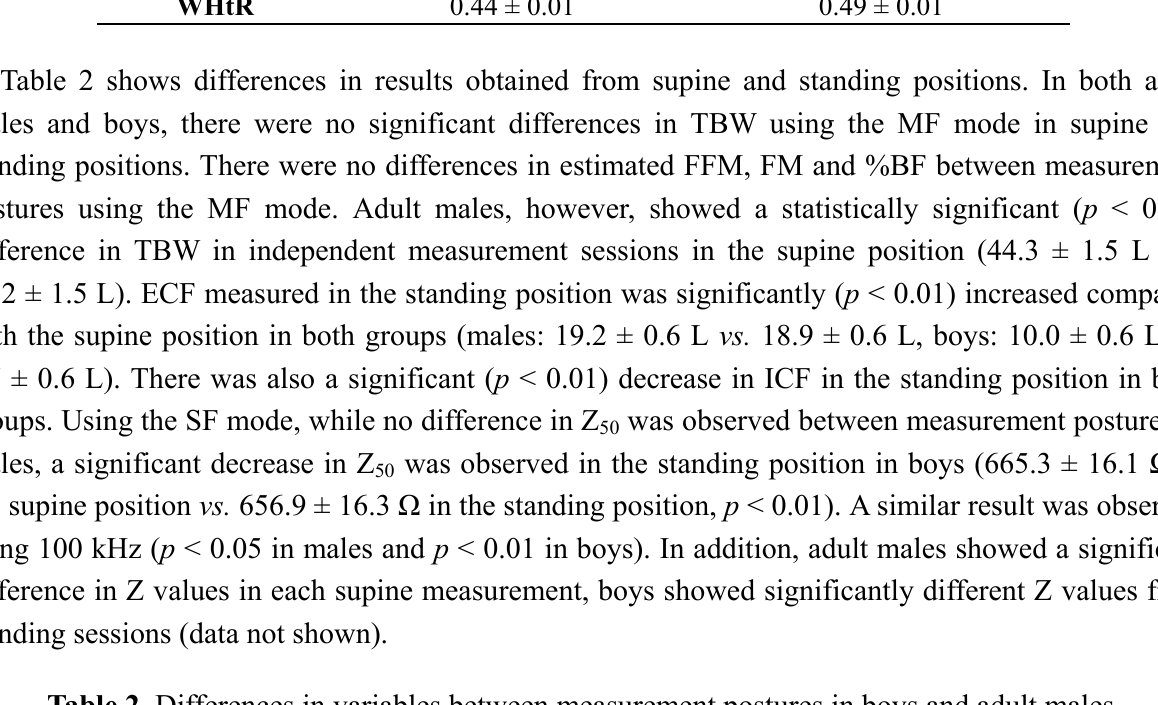
Table 2. Differences in variables between measurement postures in boys and adult